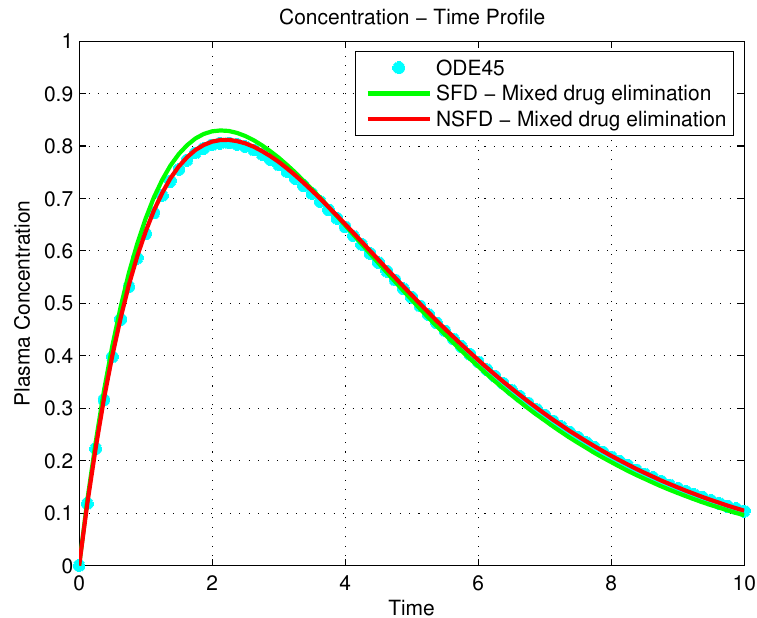
Figure 12. Comparison of methods for one-compartment extravascular administration that follows mixed drug elimination i.e., NSFD scheme (80) and SFD scheme (81) is compared with